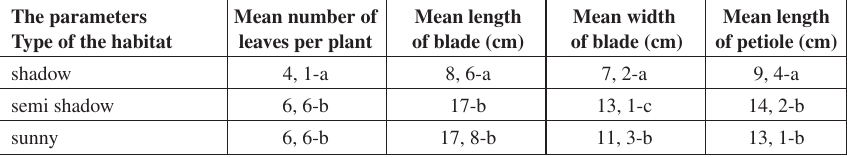
Table 1. The variation of blade length of Telekia speciosa (Schreb.) Baumg. at different habitat. The parameters Mean number of Mean length Mean width Mean length Type of the habitat leaves per plant of blade (cm) of blade (cm) of petiole (cm) shadow 4, 1-a 8, 6-a semi shadow 6,